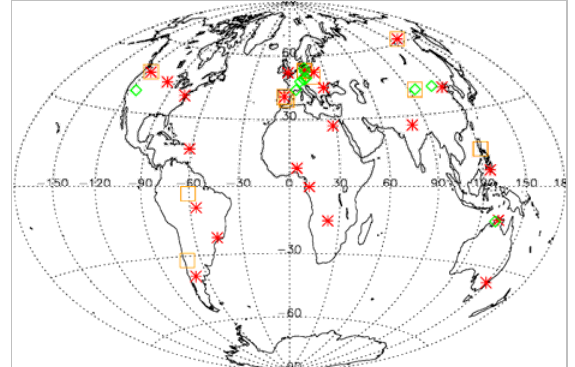
Figure 3. Geographical distribution of the 24 selected Aeronet test sites for the L2A Calibration (core + back-up sites).